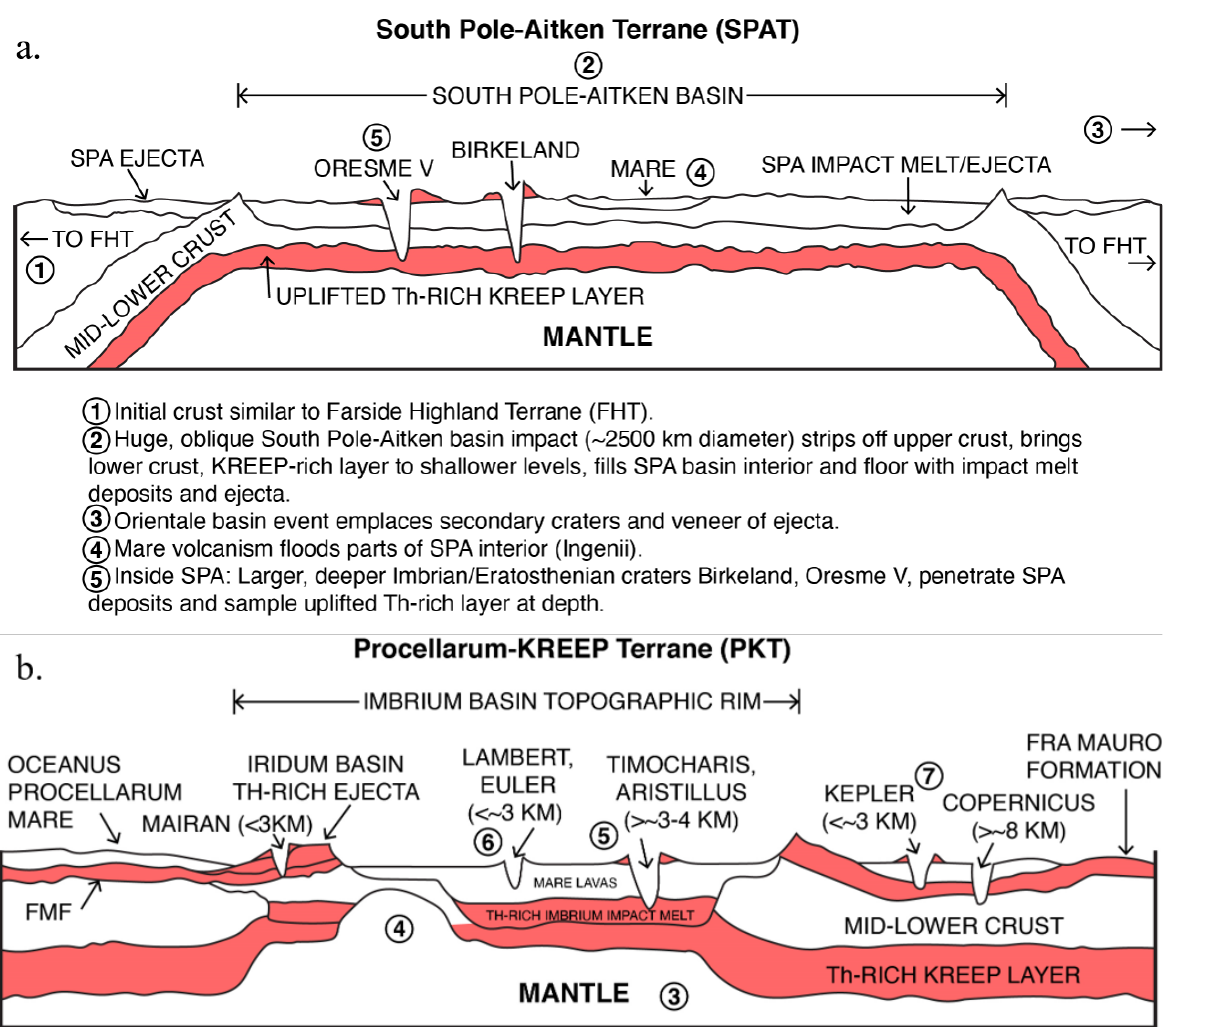
Figure 4. Reconstructed crustal cross-sections illustrating the sequence of impact events interpreted from crater/basin age and size in ( a ) South Pole–Aitken Terrane (SPAT; oblique, shallow excavation model) and ( b ) Procellarum KREEP Terrane (PKT). Compare crustal thickness and stratigraphy to original interpretation in Jolliff et al. 2000 [9]. 4.2. Origin of the Procellarum KREEP Terrane On the basis of these stratigraphic and geometric relationships as well as new crustal thickness data (Figure 4b) [49,55], we interpret the high Th value distribution in the PKT and SPAT to be related to sequential oblique and nearer-vertical impacts. In order to